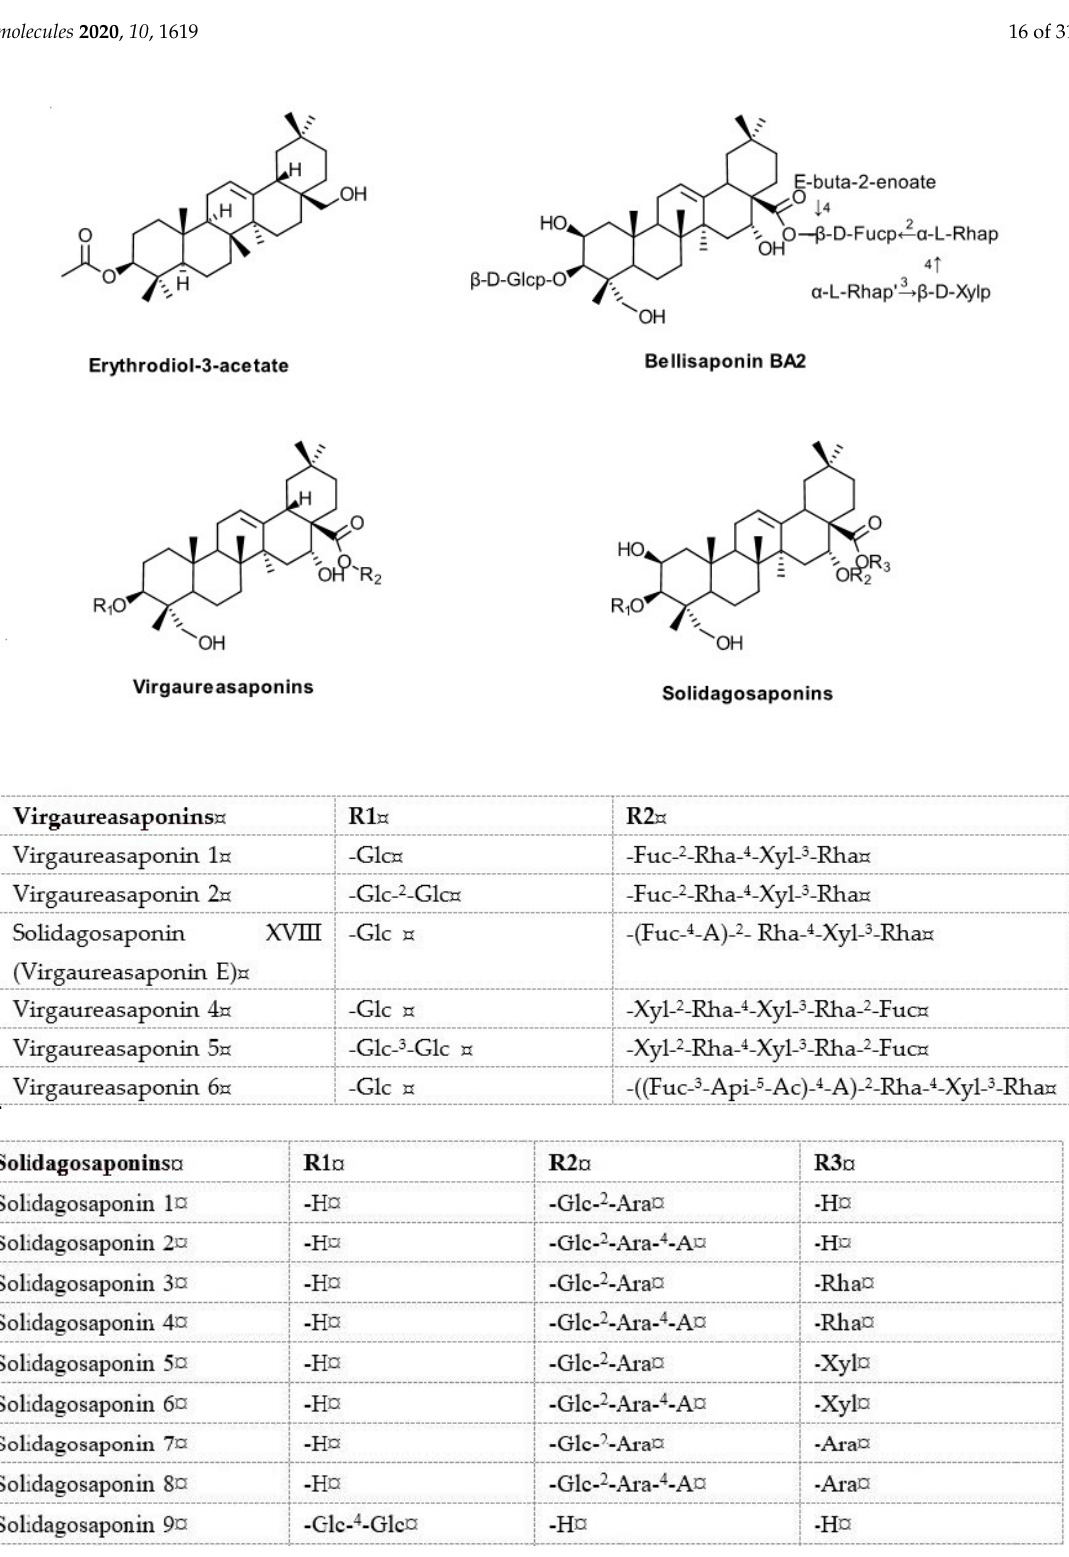
Figure 7. Saponins from S. virgaurea L.